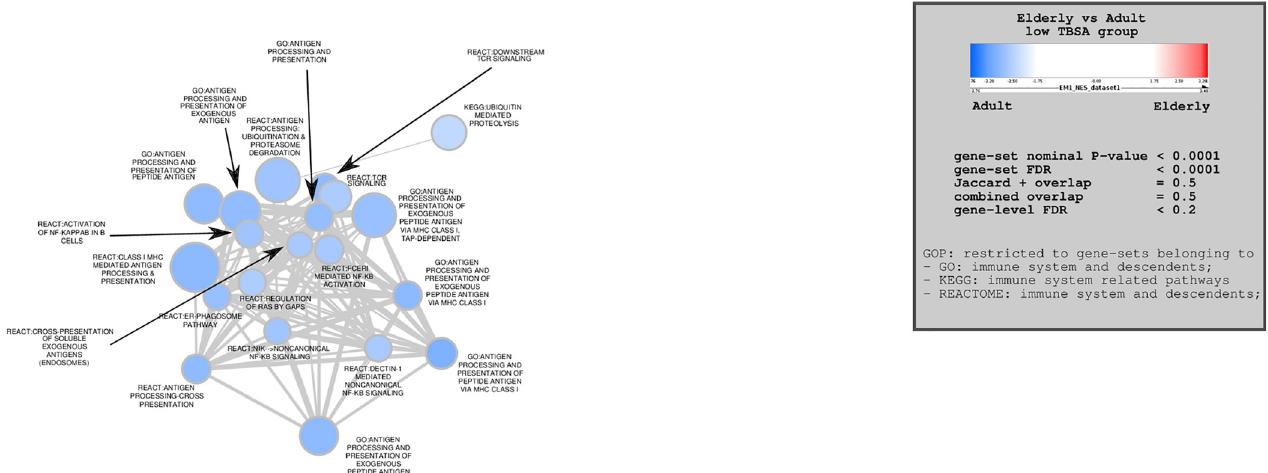
Fig 3. Enrichment map outlining significantly altered immune-related pathways for comparison group 3 (low TBSA). Blue nodes represent pathways downregulated in the elderly group, red nodes represent pathways upregulated in the elderly group. Node size is proportional to gene set size.